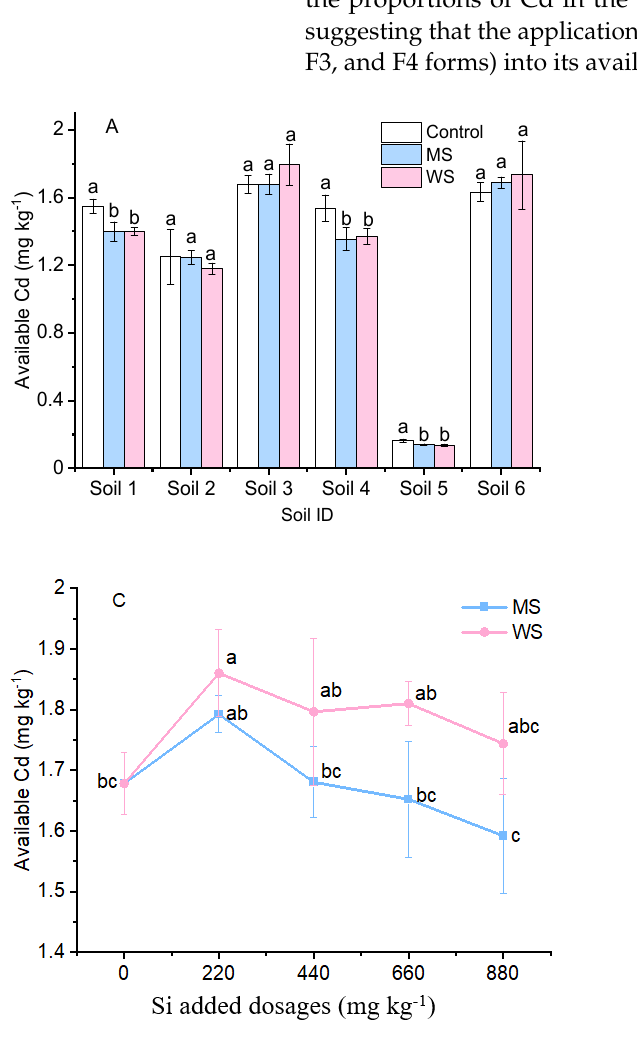
Figure 3. Effects of amendments on the Cd availability and Cd immobilization rate (%) in 440 mg · kg − 1 Si amended six soils ( A , B ) and in soil 3 under 0, 220, 440, 660, and 880 mg · kg − 1 Si added dosages ( C , D ). Control, non-amendment treatment; MS, 4A molecular sieve; WS, wollastonite. Data are means ± SE ( n = 4). Different letters above the adjacent bars or lines denote a significant ( p < 0.05) difference among the treatments in the same soil.